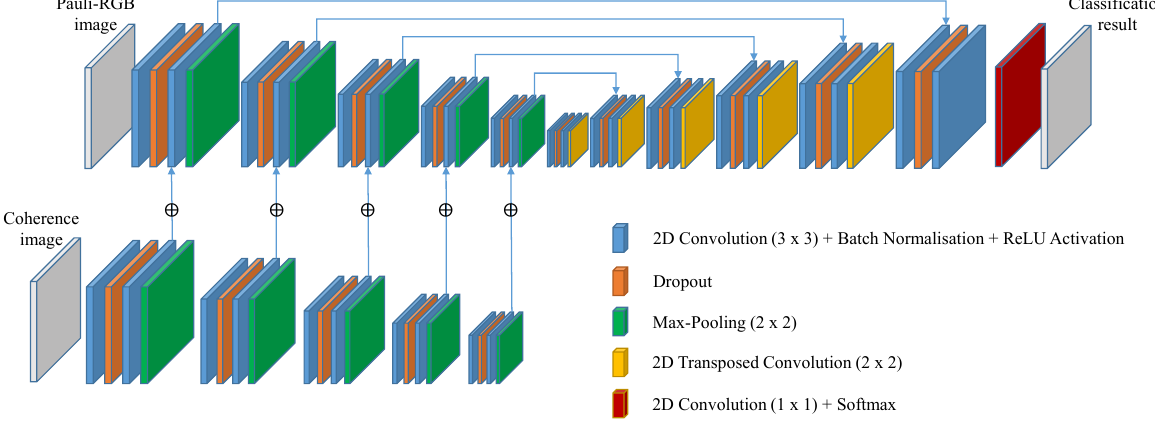
Figure 1. Architecture of the proposed Fused U-Net with Pauli-RGB image and coherence image as inputs. on the generic encoder-decoder paradigm. Within the encoder stage, high-level features are extracted from the input layer, while the decoder stage is designed to consecutively up-sample the feature maps to the original input